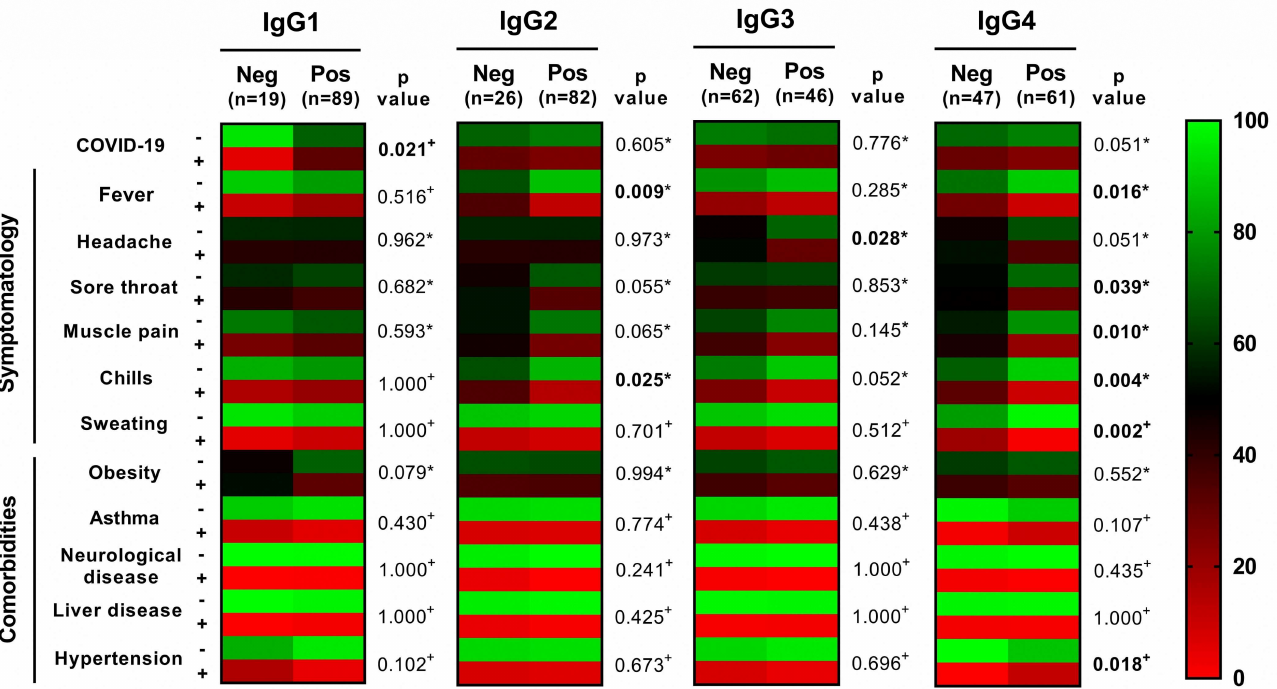
Figure 2. Association between IgG subclasses with COVID-19 symptoms and comorbidities. Heat map showing the frequency of symptoms, comorbidities, and COVID-19 infection in health workers in negative and positive samples to IgG subclasses. Four heat maps were constructed and correspond to each subclass. Frequency and p -value were added. + Fisher’s exact, *